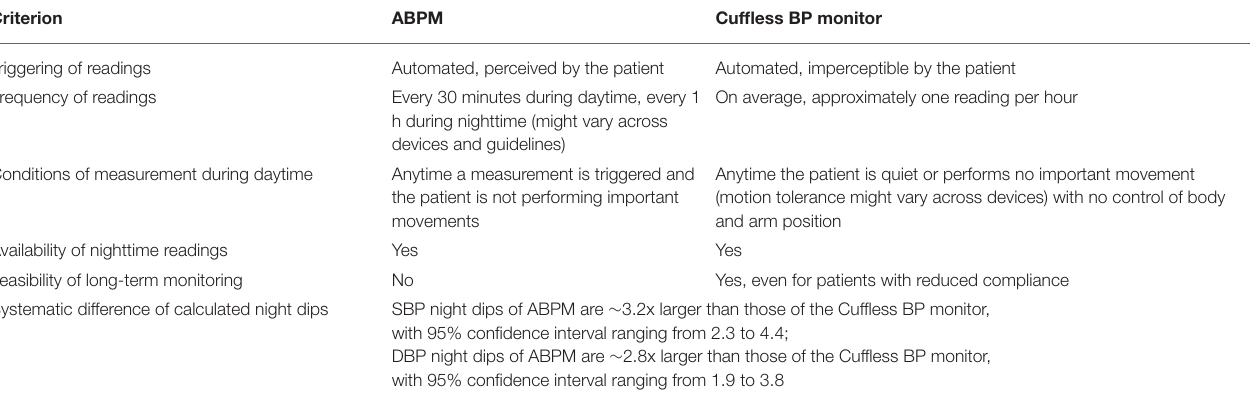
TABLE 4 | Guidance for the interpretation of BP phenotyping data obtained from a continual cuffless BP monitor when compared to BP characteristics obtained from